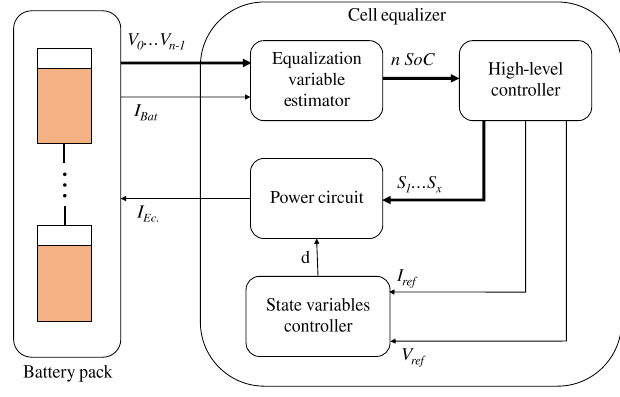
Figure 1. General diagram of a cell